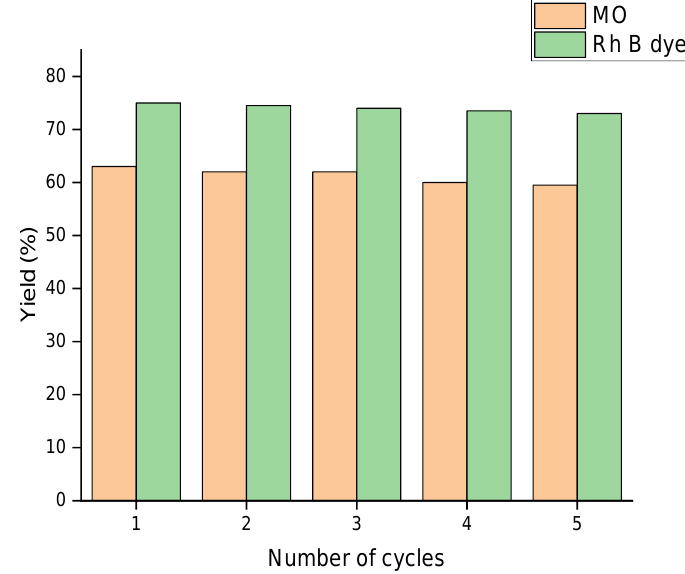
Figure 7. Redegradation efficiency of complex ( 4 ) for the MO and RhB dyes.